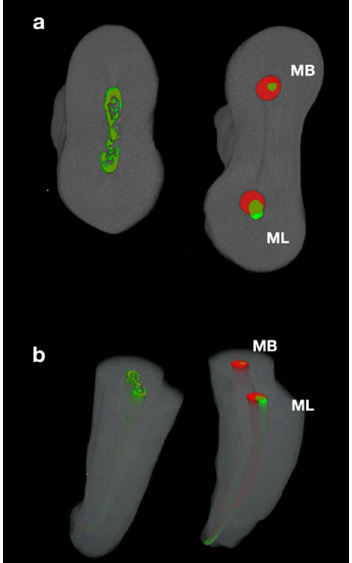
Figure 2. Micro-CT scan matching of pre- and post-shaping volumes from a coronal ( a ) and lingual ( b ) projection. Note the difference between pre-operative (green) and post-shaping with WaveOne Gold Primary (red) volumes. In this representative sample the mesial root was shaped with (ML) and without (MB) brushing motion in the two different root canals. Note the wear at the furcation level “danger zone” especially in the ML canal.